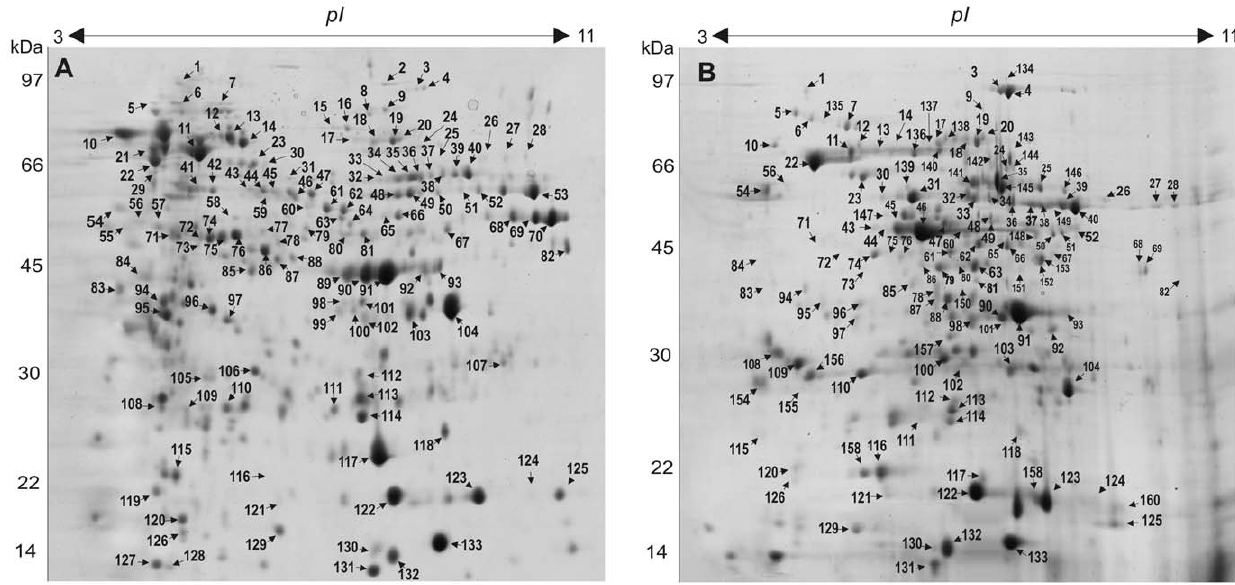
Figure 2. Proteins detected in the secretome of yeast cells and mycelia of Paracoccidiodes via 2D-gel analysis. Protein profile generated after the separation of the secreted fraction of proteins by yeast cells ( A ) and mycelia ( B ) using 2D-eletrophoresis (first dimension: IEF pH range 3 –11 non-linear, second dimension: 12% (w/v) SDS-PAGE) and visualized using Coomassie brilliant blue staining. The 2-D gel images of three biological replications of each phase were compared to identify the differential expression levels of proteins using Image master 2D Platinum software. The protein spots that were identified via MS/MS are numbered and listed in Table S1. The pH gradient is shown above the gel, and the molecular mass protein standards (kDa) are indicated to the left of the gels.